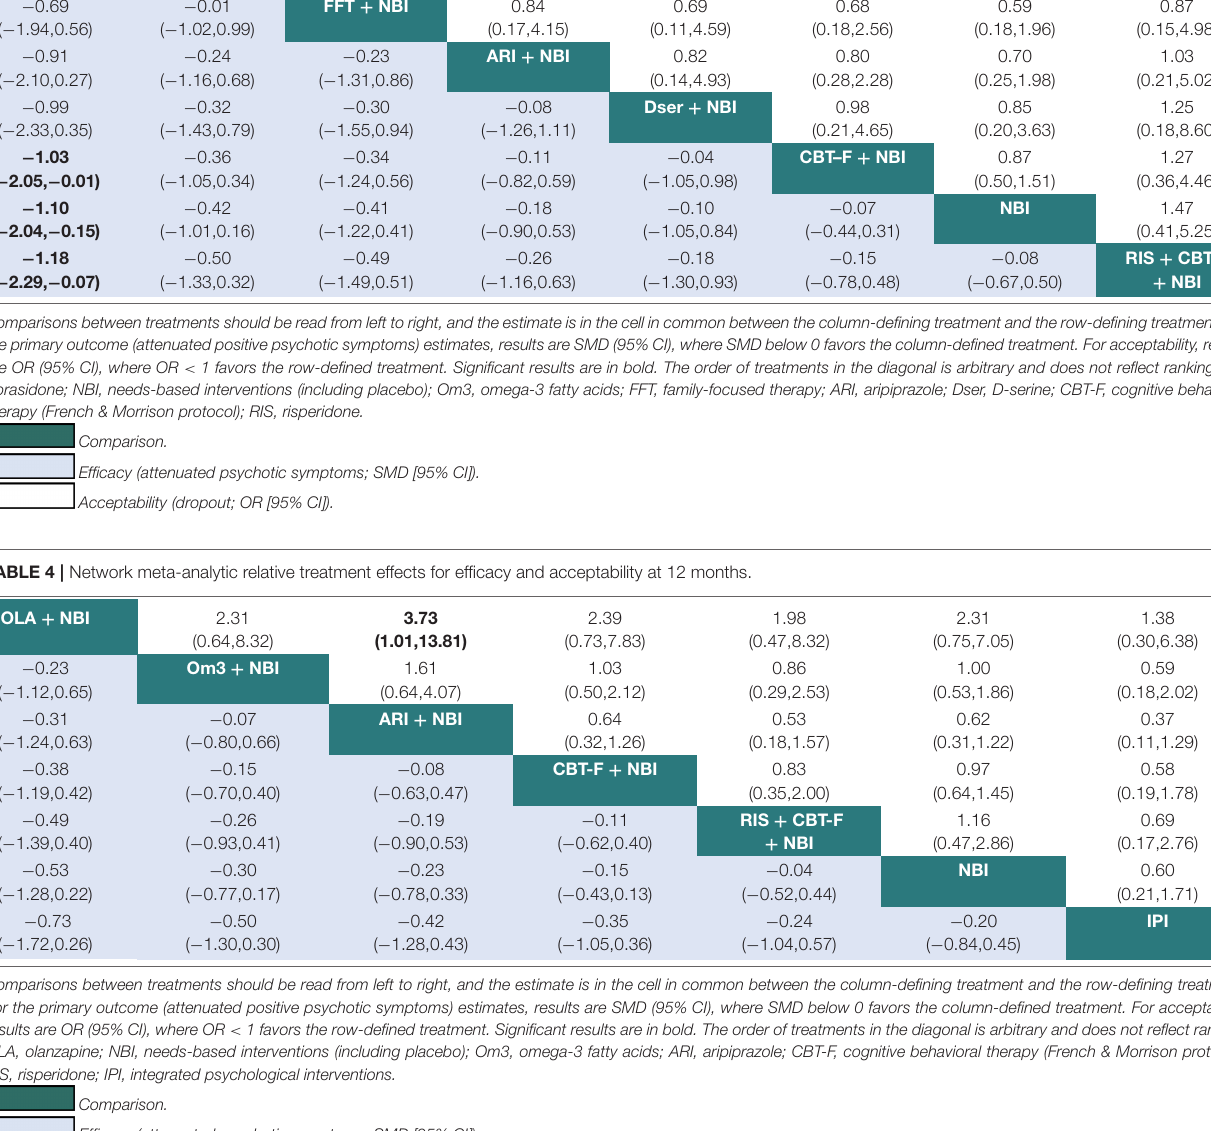
Comparisons between treatments should be read from left to right, and the estimate is in the cell in common between the column-defining treatment and the row-defining treatment. For the primary outcome (attenuated positive psychotic symptoms) estimates, results are SMD (95% CI), where SMD below 0 favors the column-defined treatment. For acceptability, results are OR (95% CI), where OR < 1 favors the row-defined treatment. Significant results are in bold. The order of treatments in the diagonal is arbitrary and does not reflect ranking. OLA, olanzapine; NBI, needs-based interventions (including placebo); Om3, omega-3 fatty acids; ARI, aripiprazole; CBT-F, cognitive behavioral therapy (French & Morrison protocol); RIS, risperidone; IPI, integrated psychological